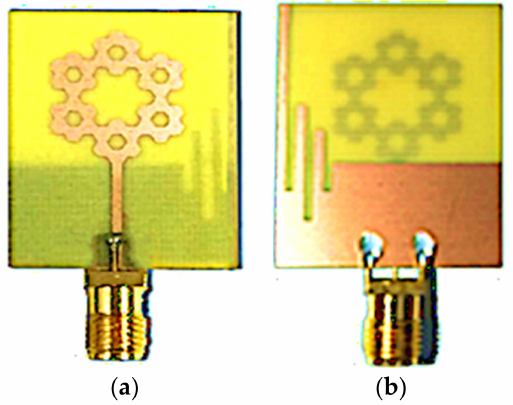
Figure 10. Manufactured prototype of the designed antenna’s ( a ), front view; and ( b ), back view.